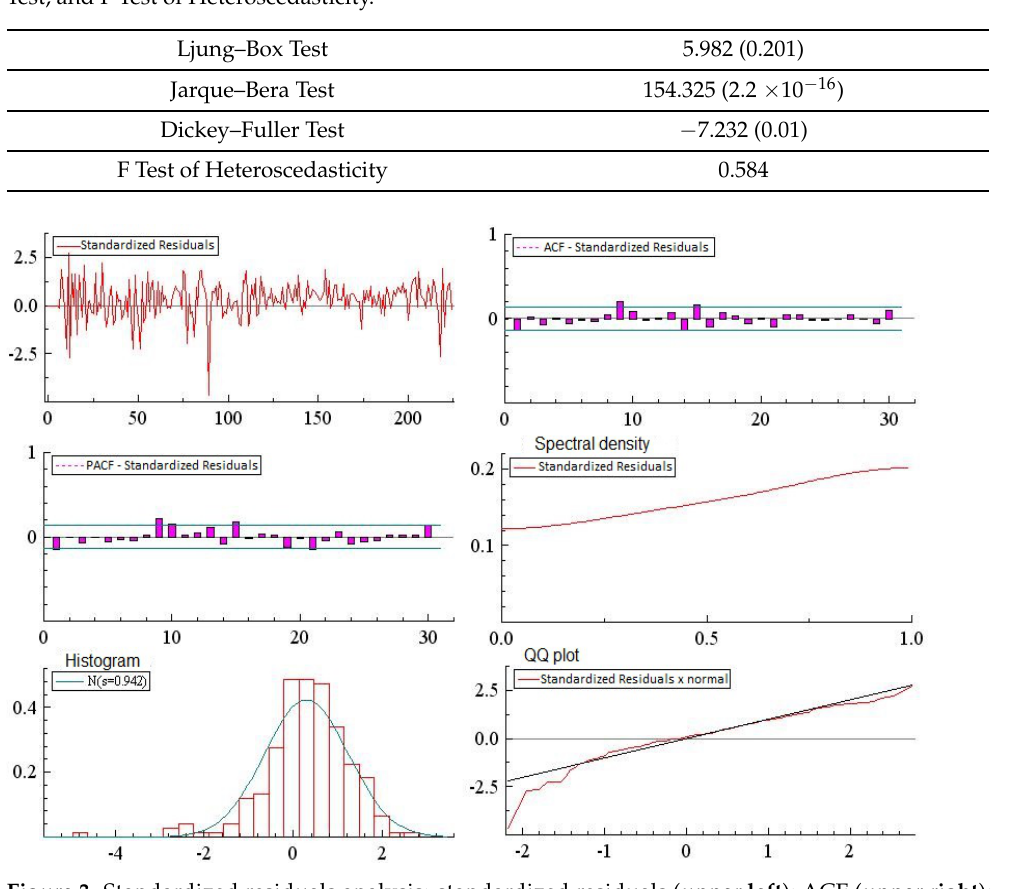
Figure 3. Standardized residuals analysis: standardized residuals ( upper left ); ACF ( upper right ); PACF ( middle left ); spectral density ( middle right ); histogram with the normal distribution over- lapped ( bottom left ); and the QQ-plot respect the normal distribution ( bottom right